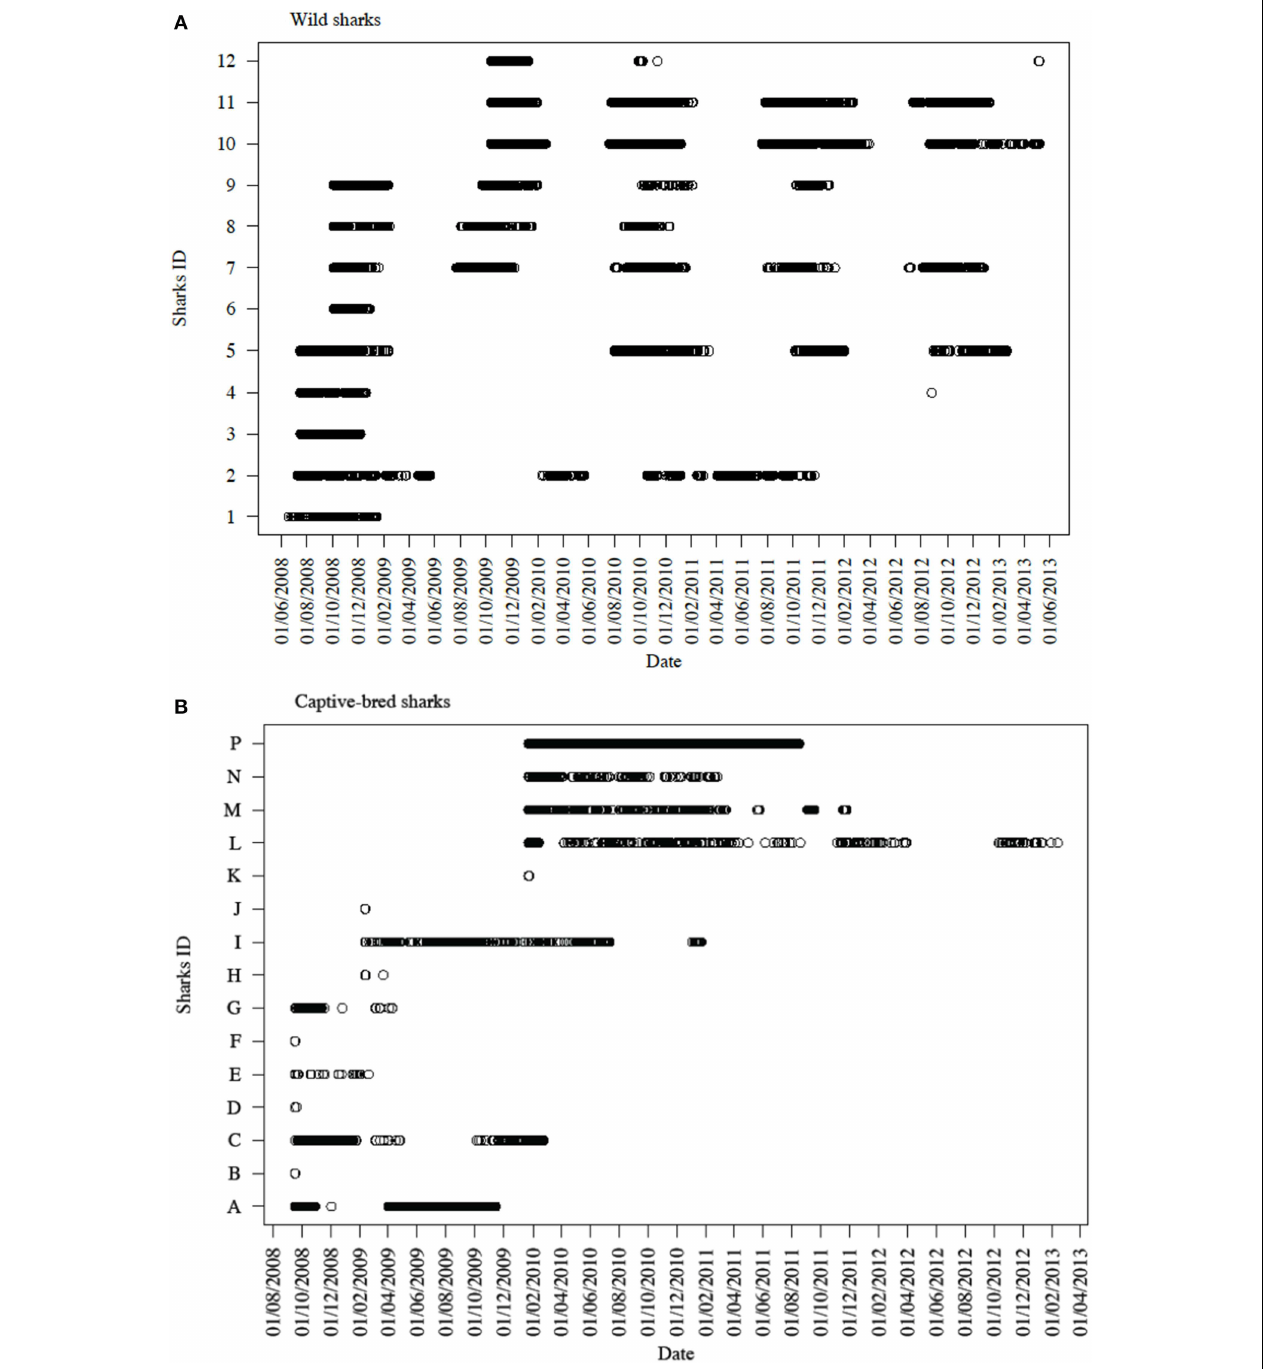
FIGURE 3 | Time series of detections across all six VR2W receivers in CTBAR for (A) all 12 tagged wild wobbegongs and (B) all 15 captive-bred sharks released into the area.